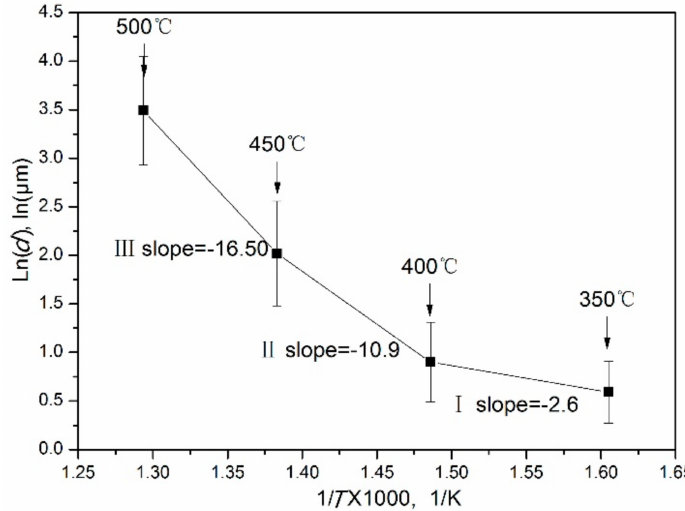
Figure 13. The boundary misorientation maps of the Mg–8.08Gd–2.41Sm–0.30Zr (